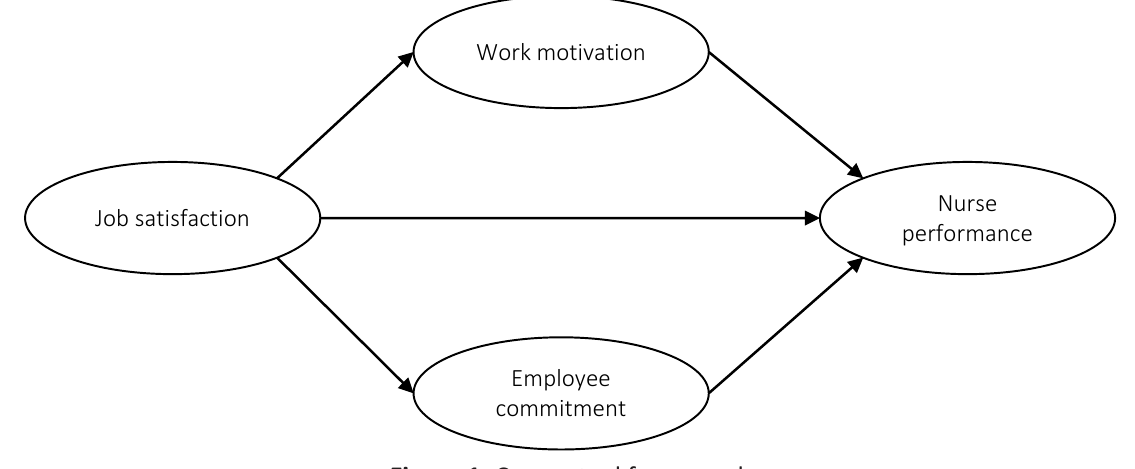
Figure 1. Conceptual